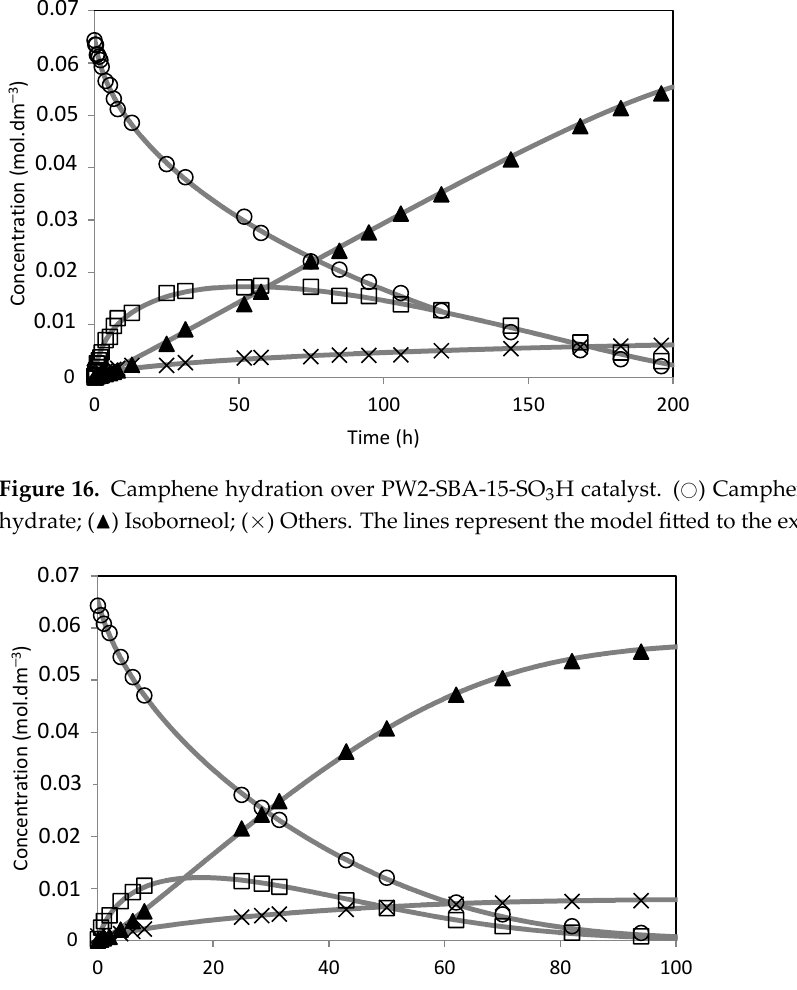
Figure 15. Camphene hydration over PW1‑SBA‑15‑SO 3 H catalyst. ( # ) Camphene; ( □ ) Camphene hydrate; ( ▲ ) Isoborneol; ( × ) Others. The lines represent the model fitted to the experimental points.